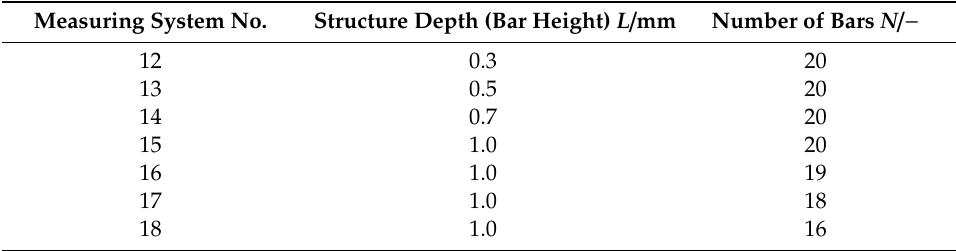
Table 3. Geometric dimensions of the bars, R = 15